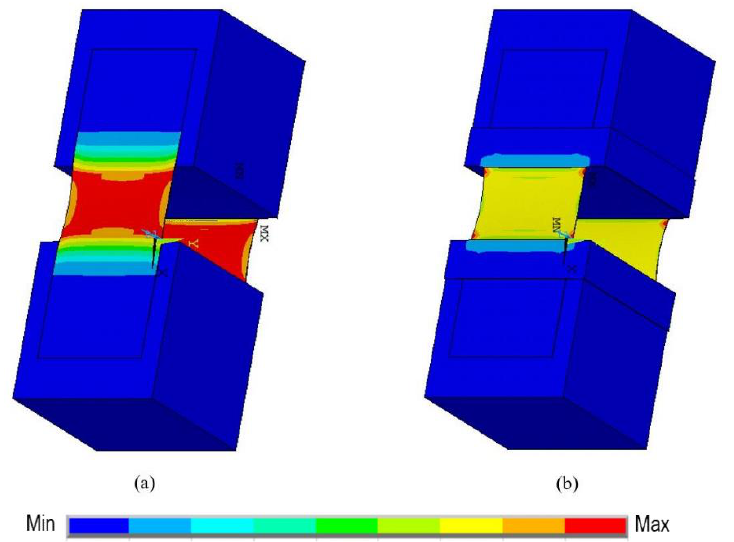
Figure 14. Stress distribution ( a ) without anchorage; and ( b ) with anchorage.